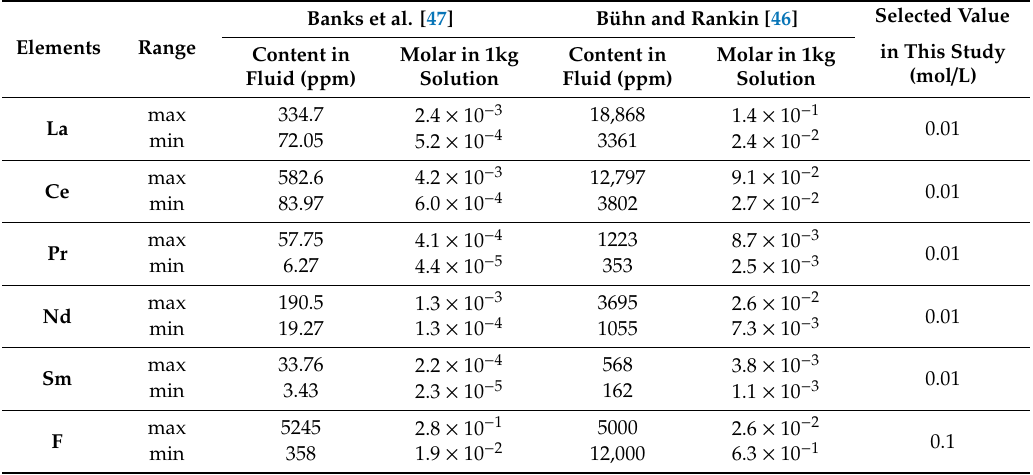
Table 2. Composition of several vital elements in fluids derived from alkali igneous rock and carbonatite, and the initial composition of the modelled solution in this